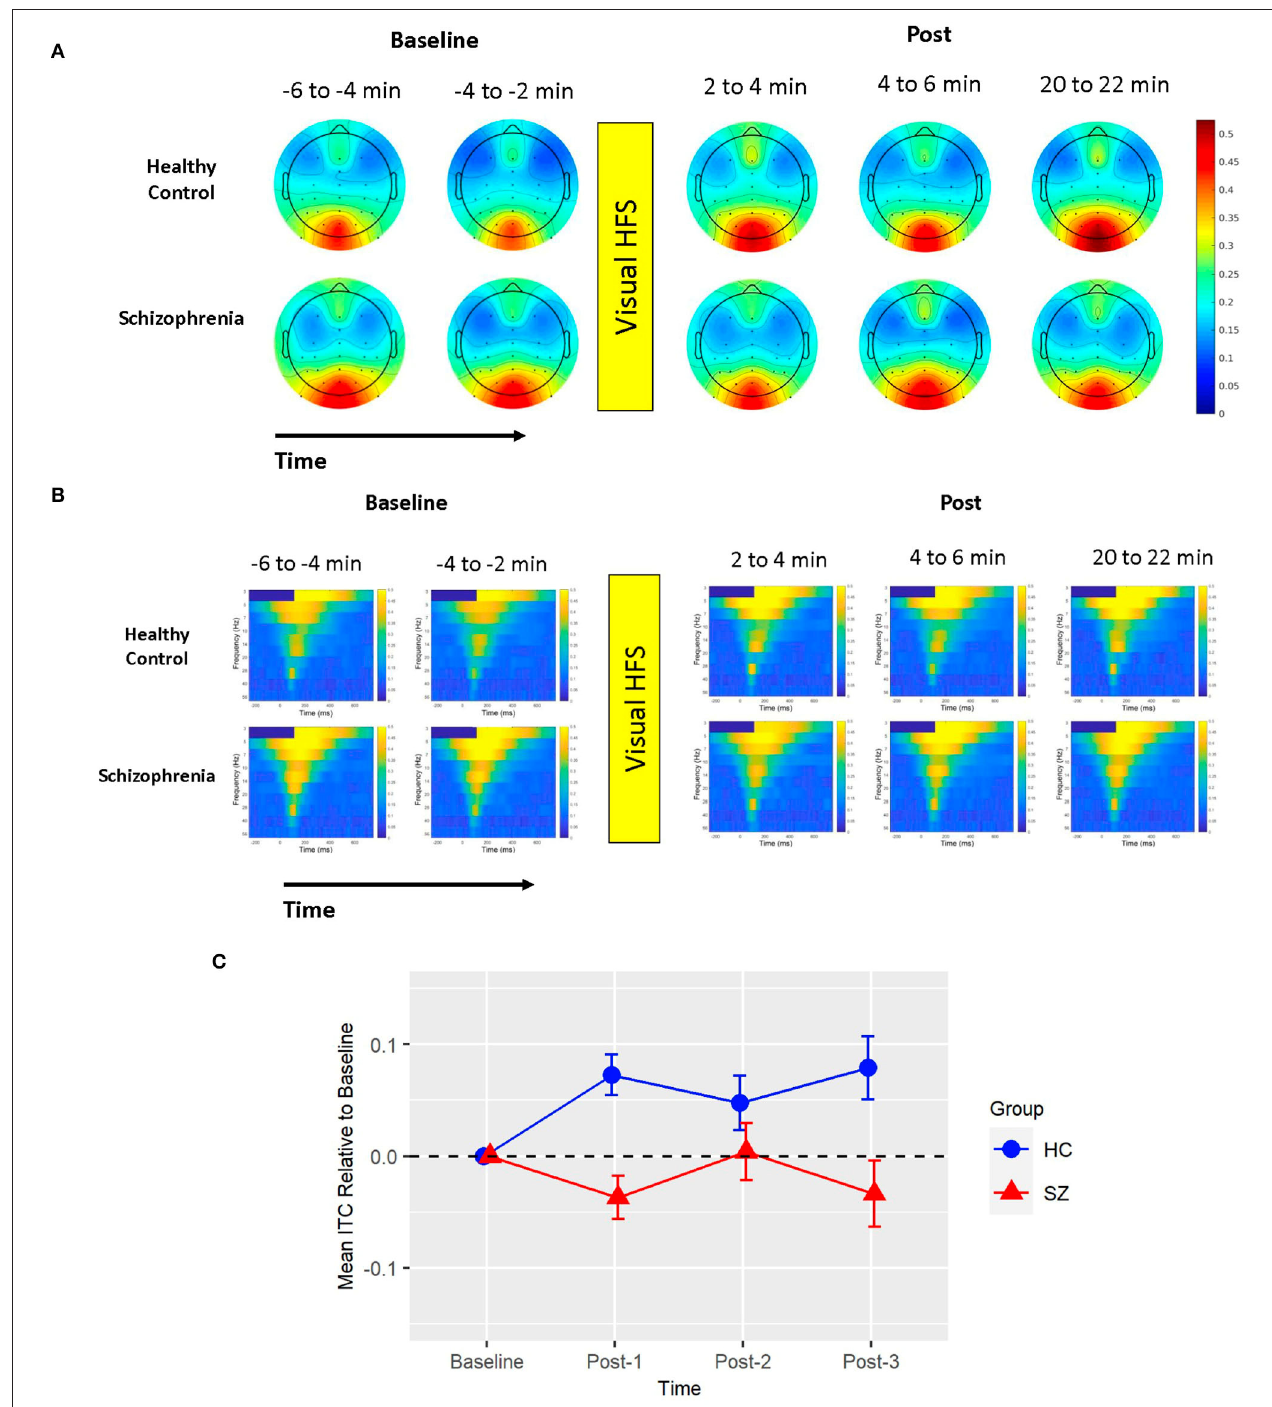
FIGURE 1 | Mean ITC. (A) Voltage scalp topography maps are shown for the mean ITC cluster, demonstrating prominent occipital/posterior activity. Topography maps are shown for each pre-VHFS and post-VHFS assessment block for healthy controls (top) and schizophrenia patients (bottom). All maps are plotted on the same voltage scale ( µ V) as indicated in the legend. (B) Group average mean ITC values are shown over the first 800ms following the onset (time = 0) of checkerboard stimuli. ITC plots are presented for healthy controls (top) and schizophrenia patients (bottom) for each assessment block pre- and post-VHFS. (C) Graph showing change in mean ITC in the identified cluster, which was dominated by 5Hz (theta) activity in the 0–496ms time window, for post-VHFS assessment blocks relative to baseline. VHFS enhanced mean ITC across post-VHFS blocks relative to baseline among healthy controls (shown in blue), whereas individuals with schizophrenia (shown in red) did not exhibit significant changes in mean ITC from baseline. Error bars denote standard errors within groups.